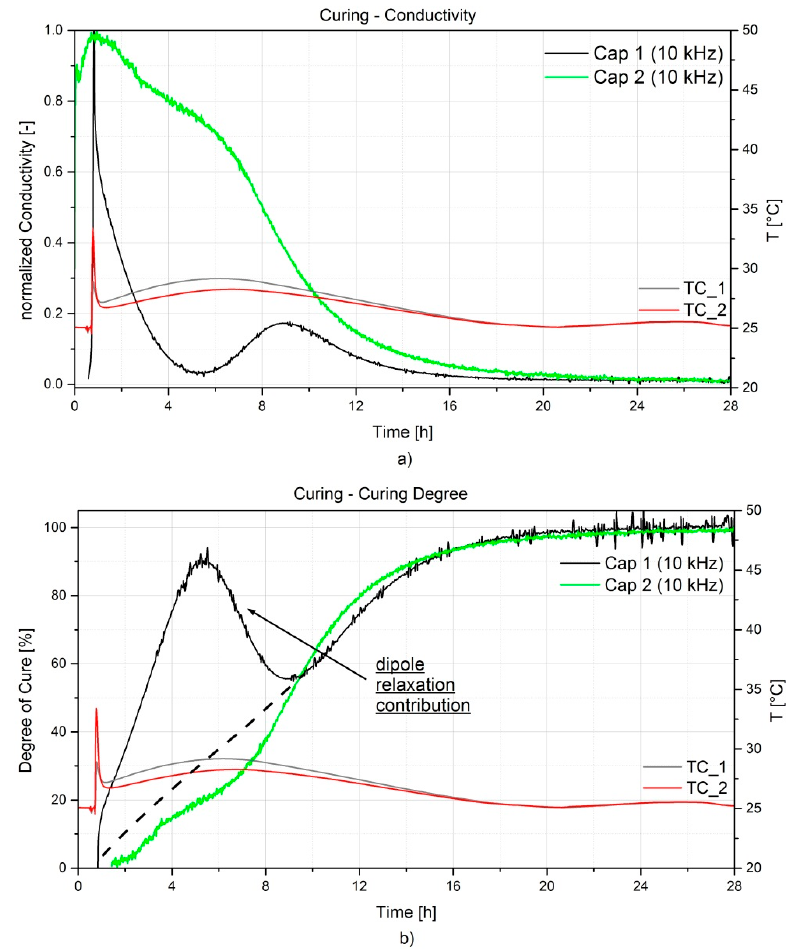
Figure 8. Evolution of the normalized ion conductivity ( a ) and of the degree of cure in % ( b ) for the two capacitive sensors during the RTM curing process of the A380 hinge arm.